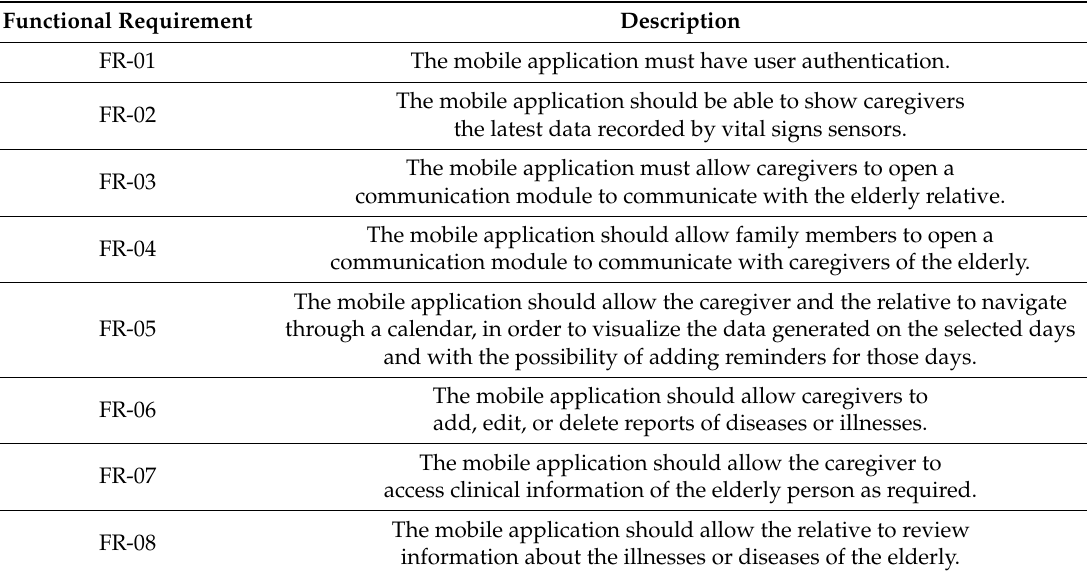
Table 2. IoMT app functional requirements.